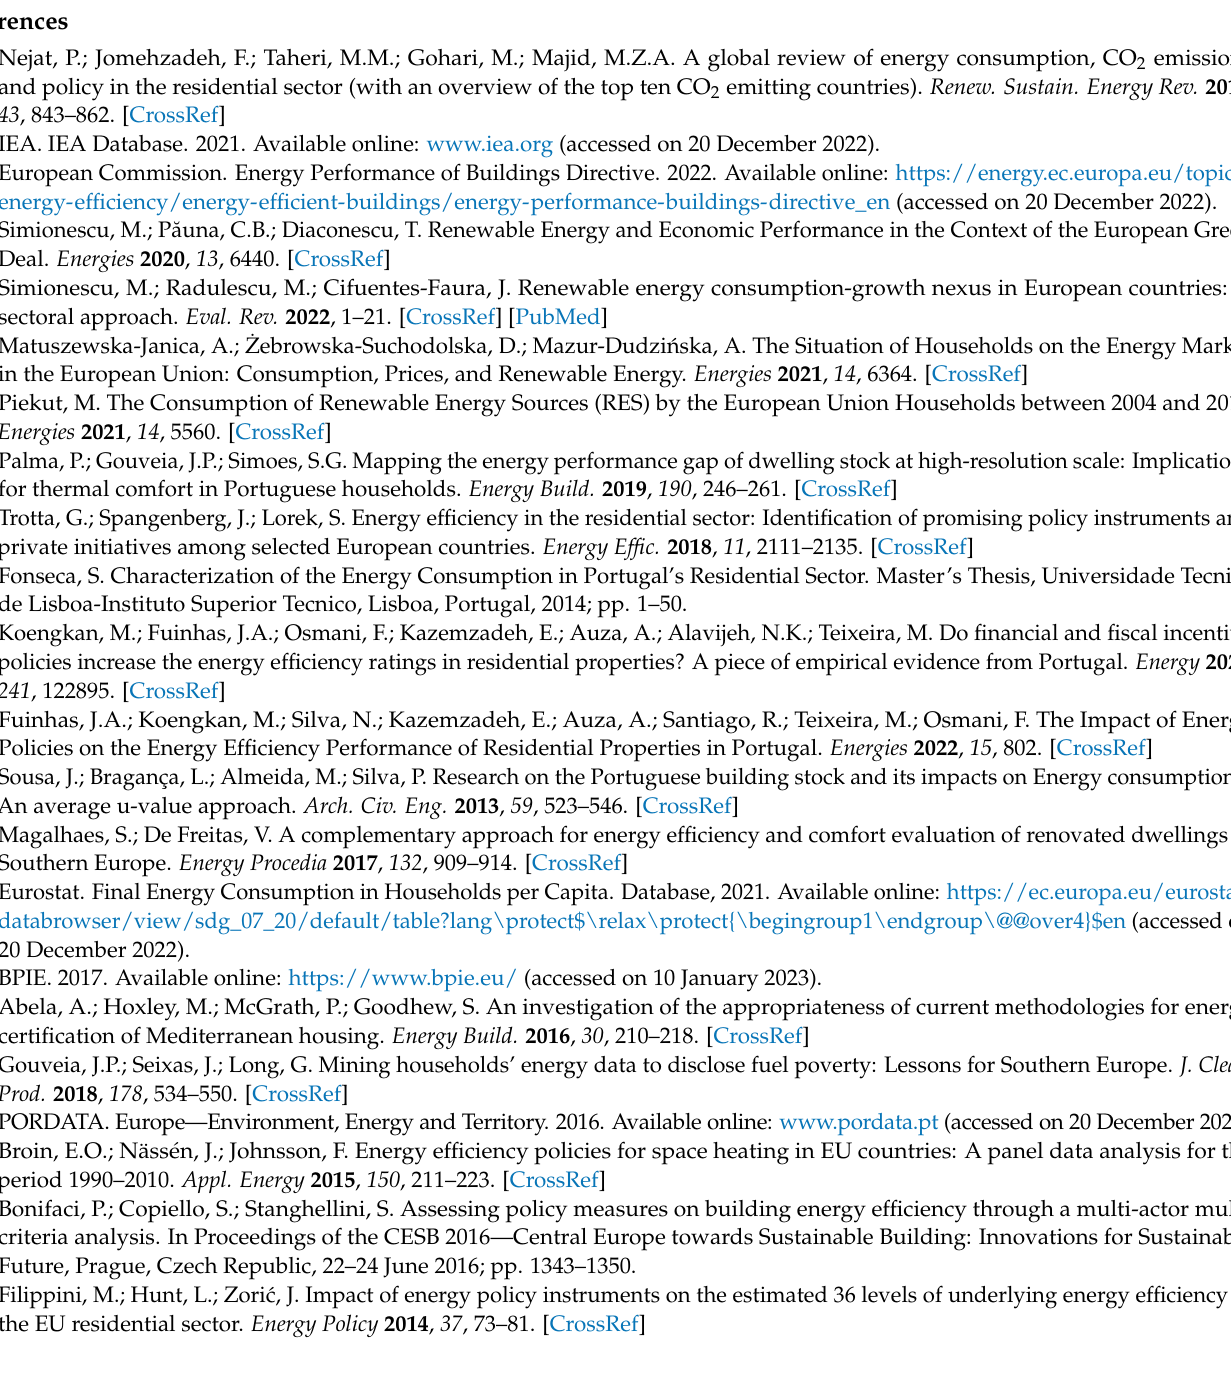
* Table 10 . Results from